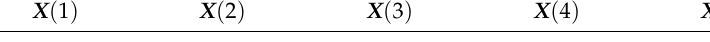
Figure 10. The mean ± std. of the absolute errors.